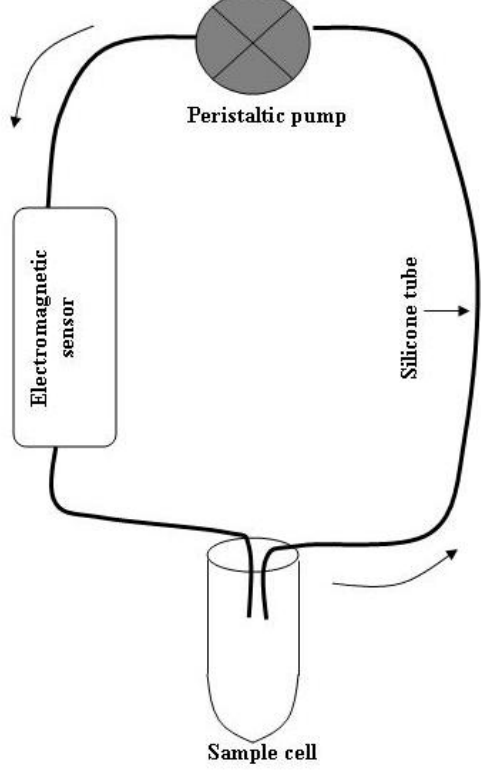
Figure 1. Block diagram of the measuring system.